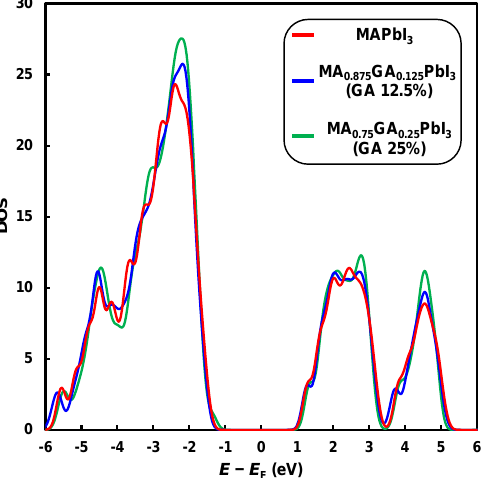
Figure 3. DOS of MAPbI 3 , MA 0.875 GA 0.125 PbI 3 , MA 0.75 GA 0.25 PbI 3 . Table 2 shows energy levels of MAPbI 3 , MA 0.875 GA 0.125 PbI 3 and MA 0.75 GA 0.25 PbI 3 from the calculation. MAPbI 3 provided a HOMO of − 17.78 eV, a LUMO − 15.00 eV, Fermi level ( E F ) of − 16.39 eV, band gap ( E g ) of 1.02 eV. The E g increased from 1.02 to 0.93 eV by the GA, which may increase the J SC and η . Gibbs energy ( G ) decreased for structure models by adding GA, which indicates the perovskite crystals are stabilized by the addition of GA.